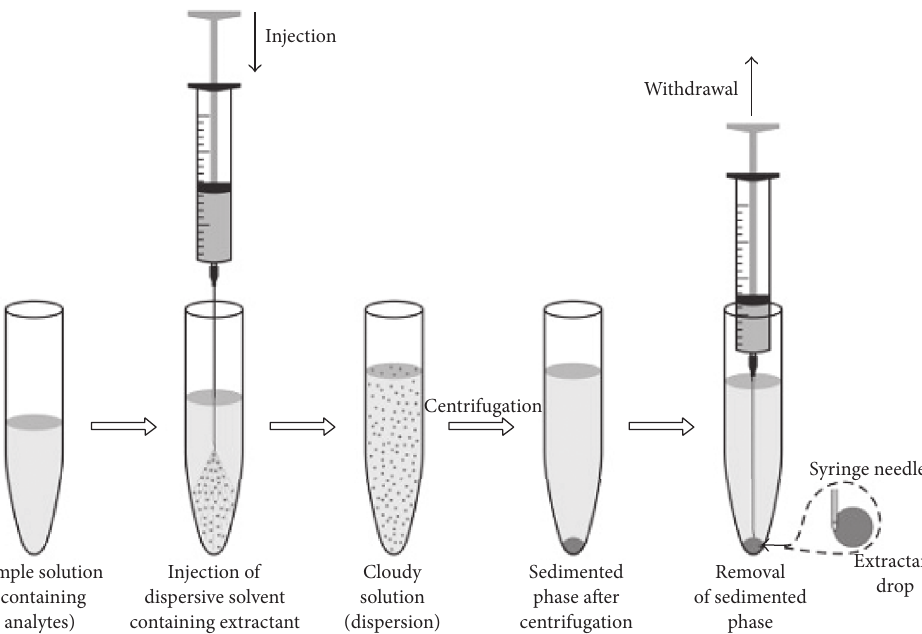
Figure 1: Schematic of DLLME technique